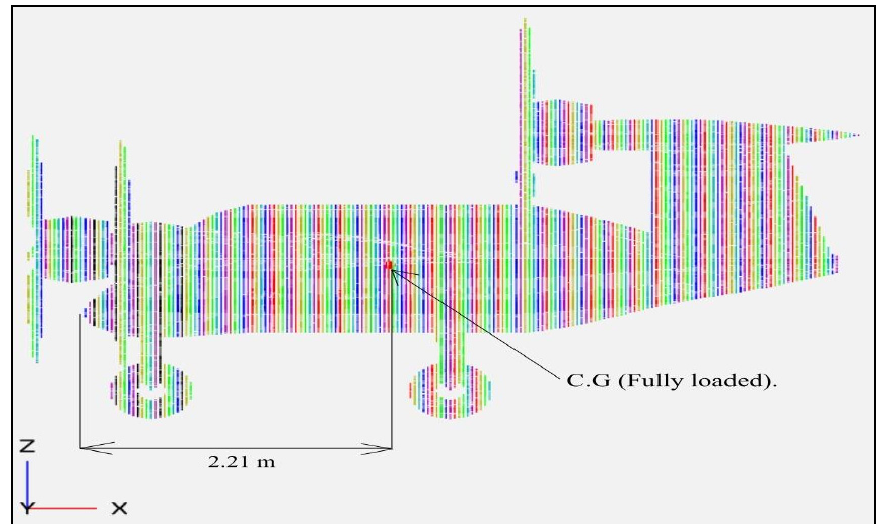
Figure 18. OpenVSP view with CG.